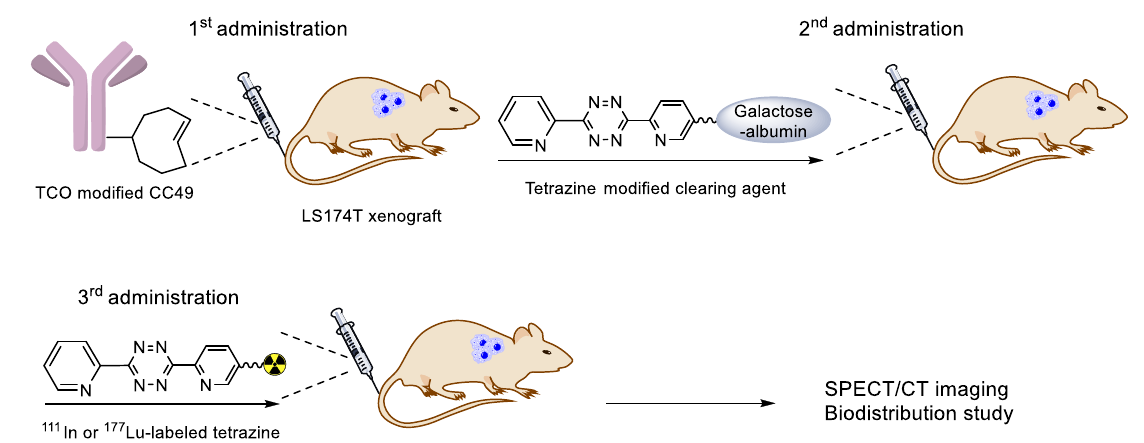
Figure 14. A modified strategy using tetrazine-bearing clearing agent.